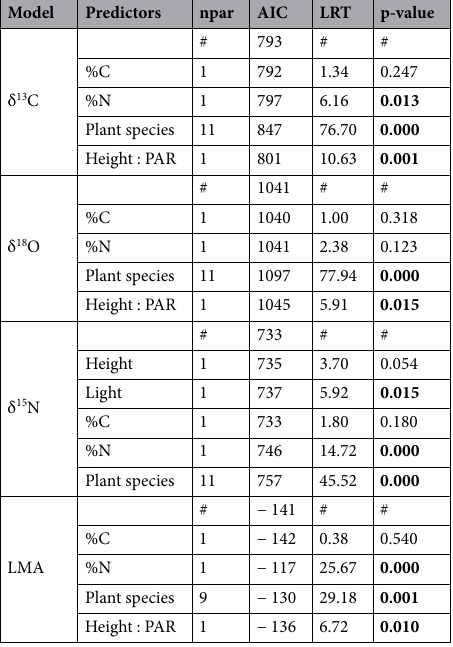
Table 2. Model results for each of the four linear mixed models. Significant effects are highlighted with p-values in